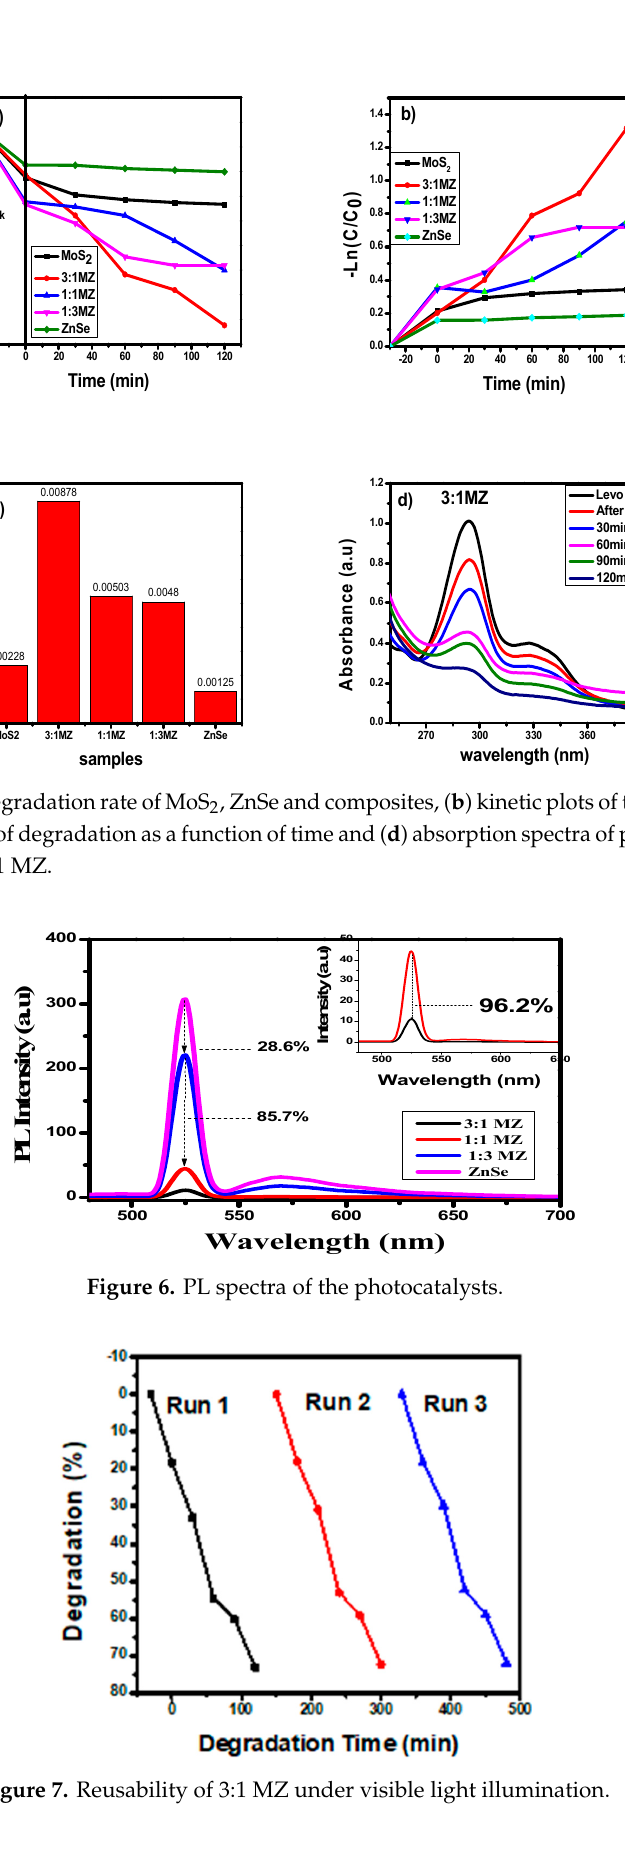
Figure 7. Reusability of 3:1 MZ under visible light illumination.